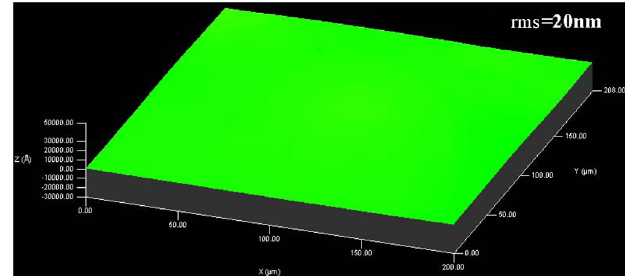
FIG. 11. (Color) The picture of the best BEP treated niobium surface scanned by high resolution 3D profilometer with the area of more than over ð 200 (cid:1) 200 Þ (cid:1) m 2